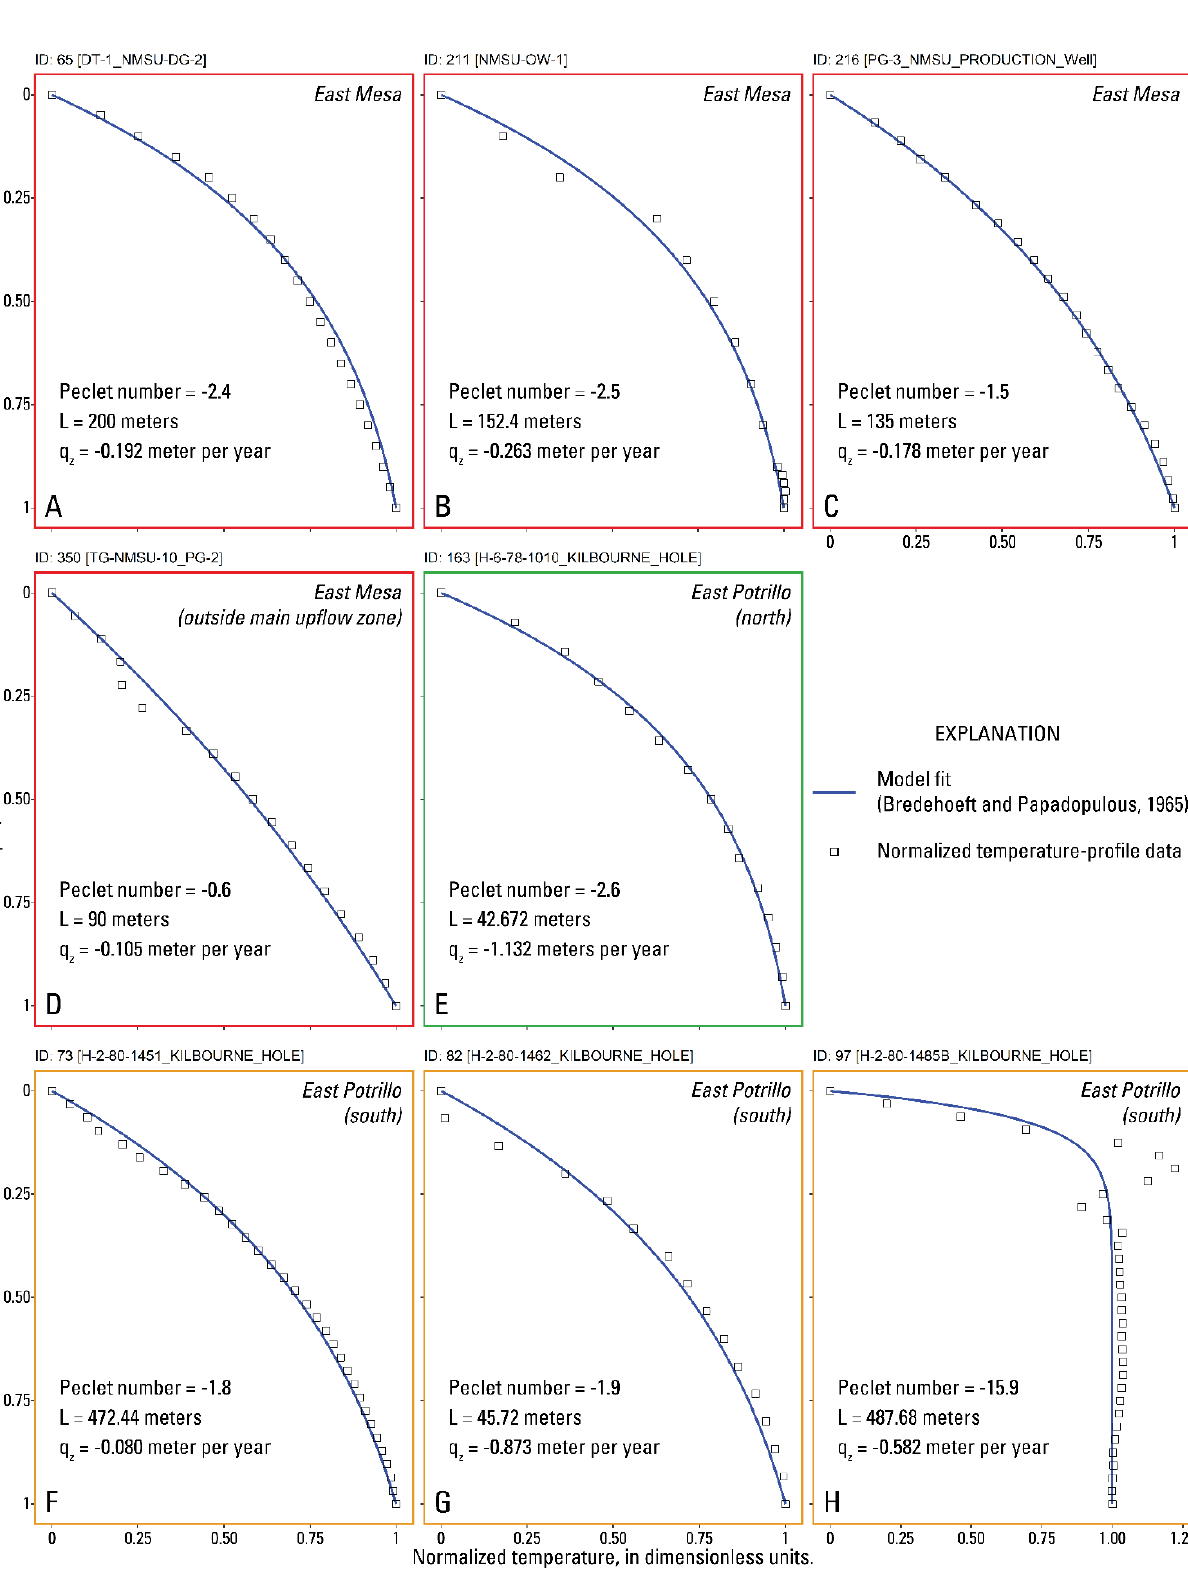
Figure 6. Normalized temperature profiles and their best-fit Bredehoeft and Papadopulos (1965) analytical solution [38] for profiles associated with the East Mesa ( A-D ), East Potrillo (north) ( E ) and East Potrillo (south) ( F-H ) upflow zones. Best-fit Peclet numbers, as determined from root-mean-squared error (RMSE) minimization, along with the length over which temperatures were analyzed (L) and estimated vertical specific discharge (q z ) are displayed on each plot for reference. The Peclet number and L are inversely related in equation 2, meaning that high Peclet numbers across small depth intervals will maximize vertical flux rates. Negative Peclet numbers and vertical specific discharge values correspond to